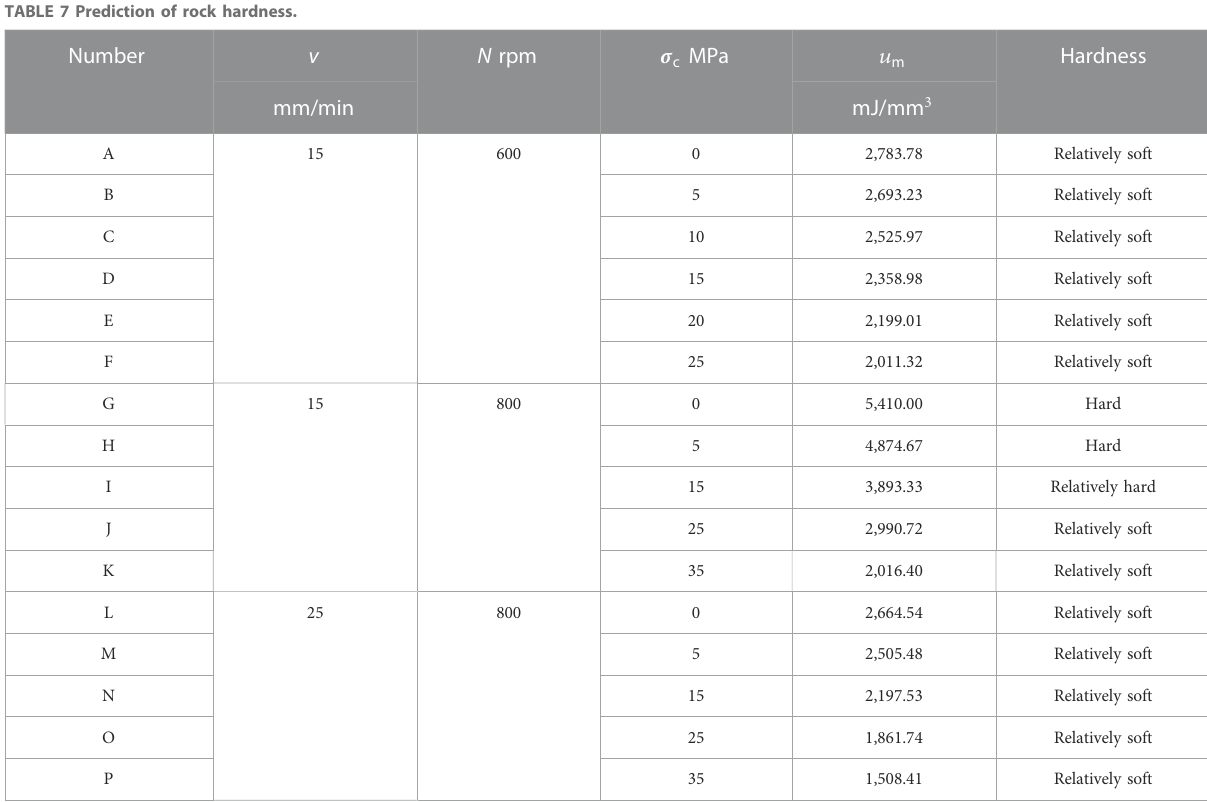
TABLE 7 Prediction of rock